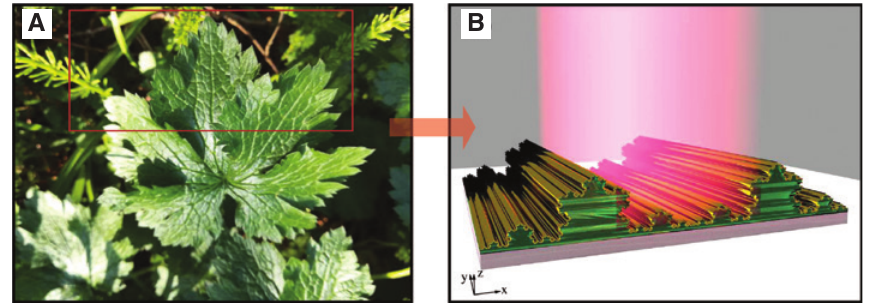
Figure 1: Bio-inspired plasmonic leaf with a fractal structure. (A) A picture of Geranium x oxonianum under the sunshine, harvesting solar energy with optimised light-matter interaction through natural selection. (B) The inspired structure using geometric abstraction from the shape of the leaf. A photoresist template (green) is formed on a glass substrate (grey). A gold film (yellow) is deposited on the template as an energy